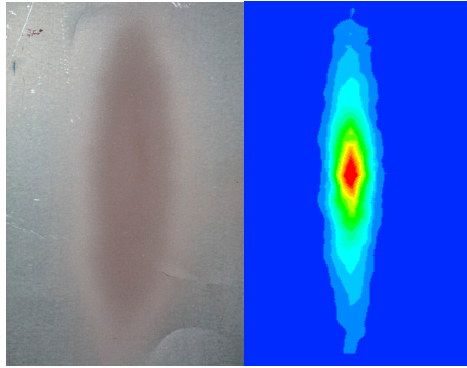
Figure 12. Comparison of experimental and simulated coating film.